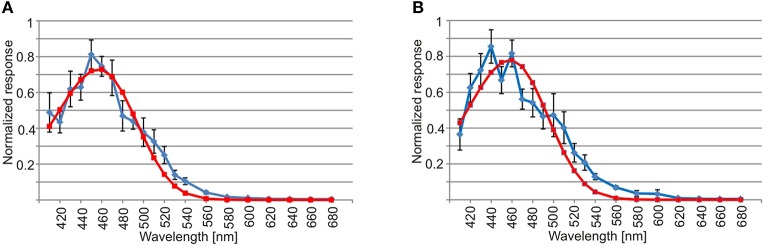
Spectral sensitivity of the lens eye. (A) The spectral sensitivity curve of the upper lens eye (blue line) has a single peak in the deep blue part of the spectrum and has a good match with the absorption curve of a 458 nm opsin (red line, AIC = −53.7). (B) Similar to the upper lens eye the spectral sensitivity of the lower lens eye (blue line) peaks in the deep blue part of the spectrum and had a best match with a single opsin peaking a 458 nm (red line, AIC = −35.9). The curves are showing mean ± S.E.M., N = 7.